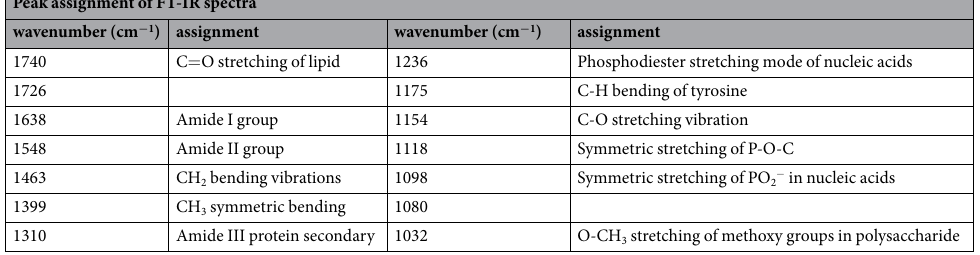
Table 1. Peak assignment of FT-IR